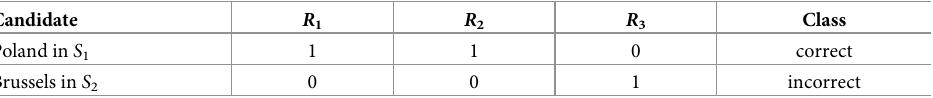
Table 1. Description matrix describing candidates (rows) according to the rules they satisfy (columns). The exam- ple shows a description matrix for candidate locations.